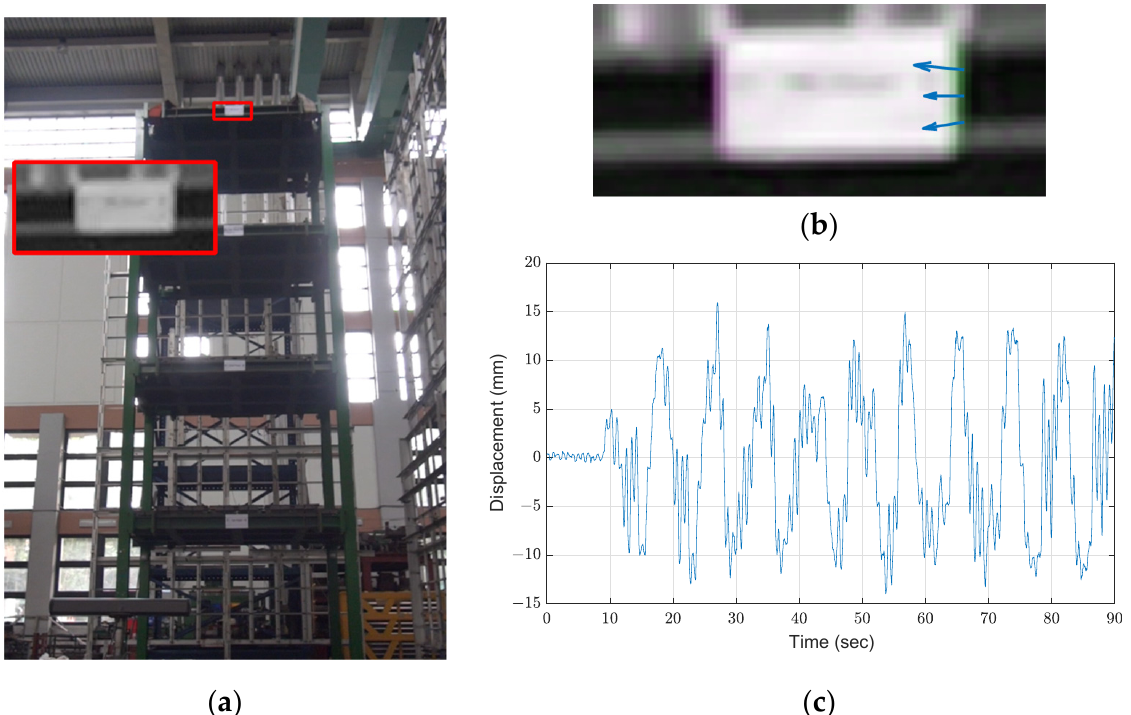
Figure 3. Results of optical flow with the Lucas–Kanade method: ( a ) ROI; ( b ) estimated optical flow; ( c ) roof displacement.